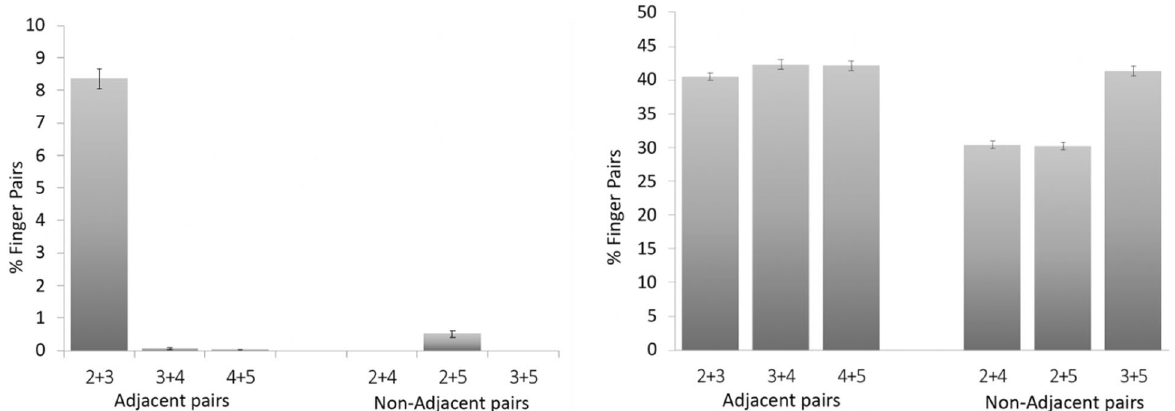
Figure 2. Percentages of handshapes in which two fingers were selected (left) or identically shaped (right) in the sign. Adjacent pairs included neighboring fingers; Non-adjacent pairs were formed by distant fingers. Two fingers were more likely to be selected or identically shaped if they were immediate neighbors (ps < 0.001). 2 = index finger, 3 = middle finger, 4 = ring finger, 5 = little